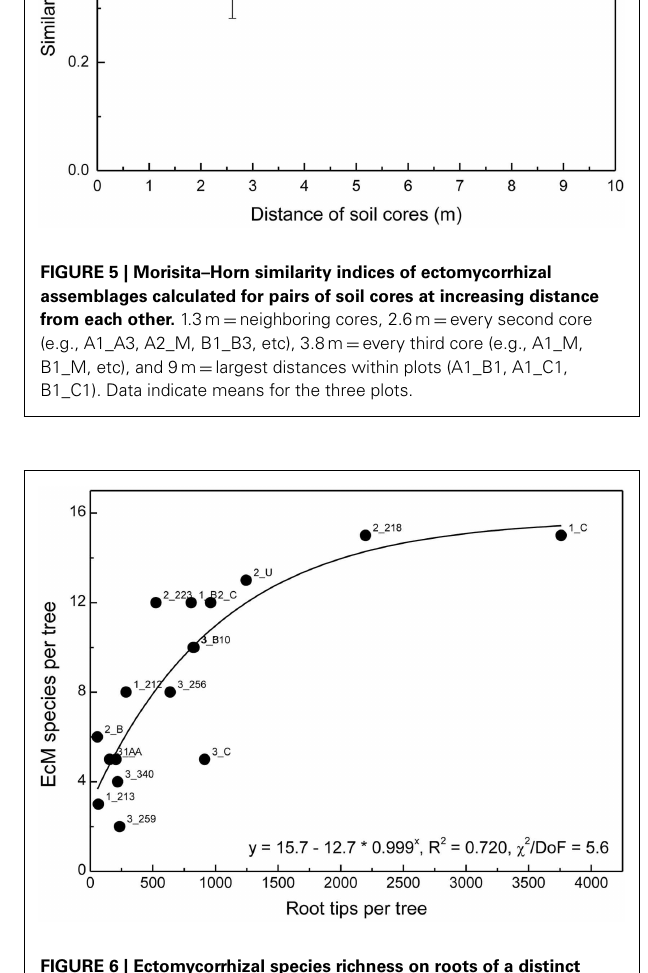
FIGURE 6 | Ectomycorrhizal species richness on roots of a distinct beech genotype in relation to the number of root tips found for this individual in all samples. Labels indicate plot number followed by tree number.The position of all trees in the plots has been shown in Lang et al. (2010).The data were fitted by a Boltzman